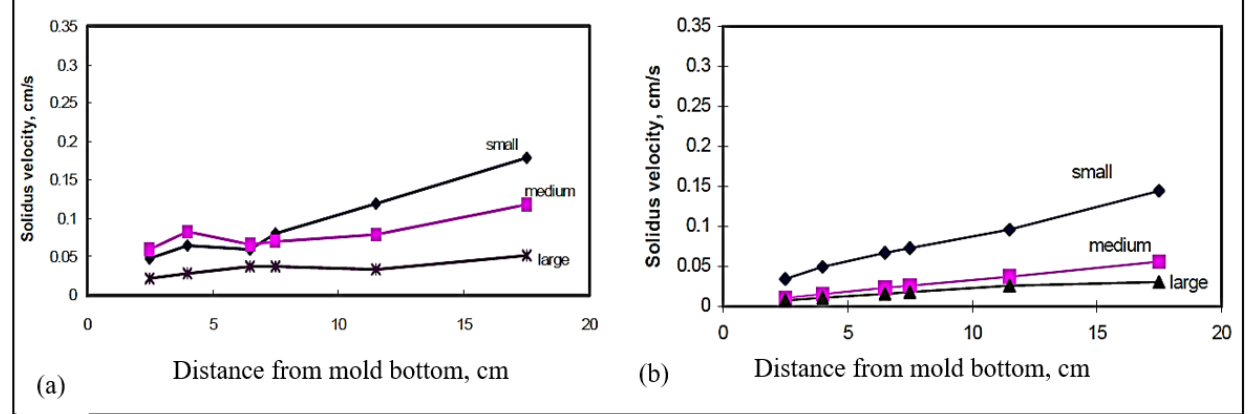
Figure 18. Average vertical solidus interface velocities in the wedge mold as a function of the distance from the bottom of the mold for ( a ) C alloy, ( b ) CB6 alloy (C + 3020 ppm Bi) for small, medium, and large molds.